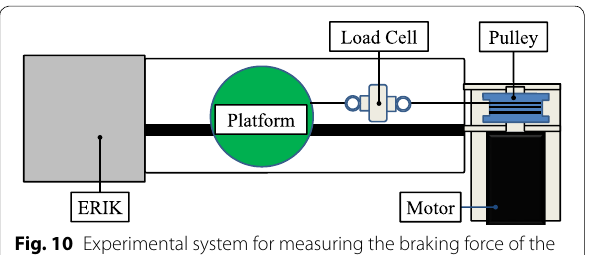
Fig. 10 Experimental system for measuring the braking force of the